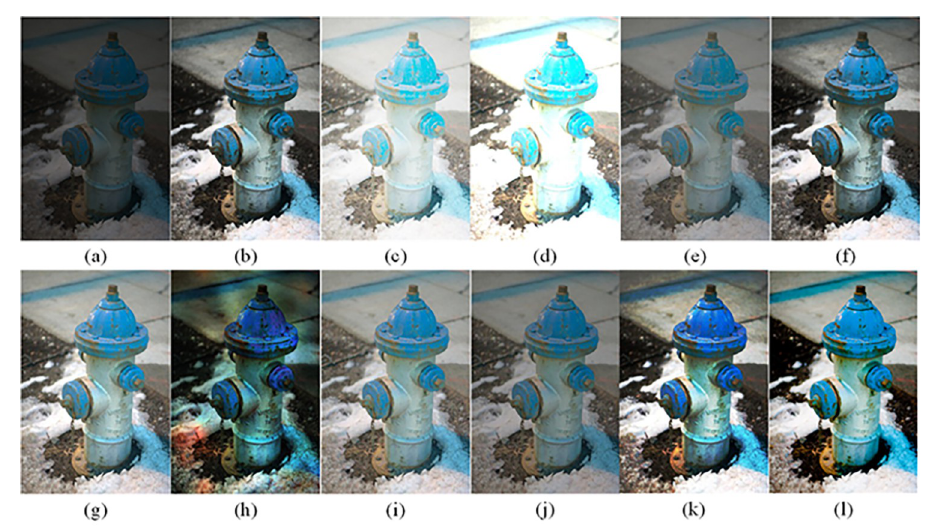
Fig 25. Comparisons of the ten algorithms in enhancing low-light image 15. (a) low-light image (b) AGCWD (c) Al-Ameen (d) BHE2PL (e) BIMEF (f) BPDHE (g) LIME (h) MSRCR (i) NPEA (j) SRIE (k) OURS (l) Normal light